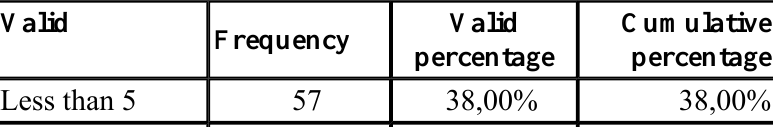
Table 2 Non-work-related e-mails per